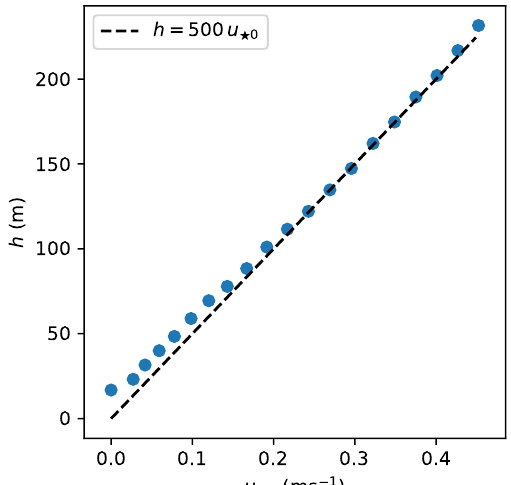
Figure 8. Boundary layer height h as a function of u (cid:63) 0 based on the single-column model results. The dashed line corresponds to Equation (19) with b = 500